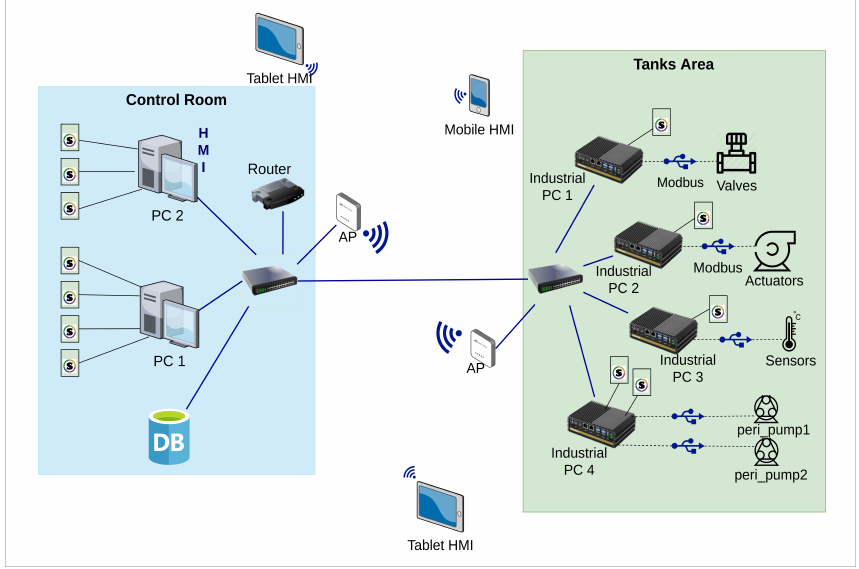
Figure 7. Embedded PC and devices platform hardware for control pH process.